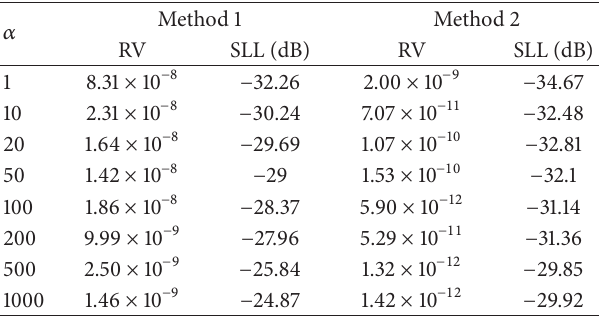
Table 4: Evaluation of the two proposed methods with different 𝛼